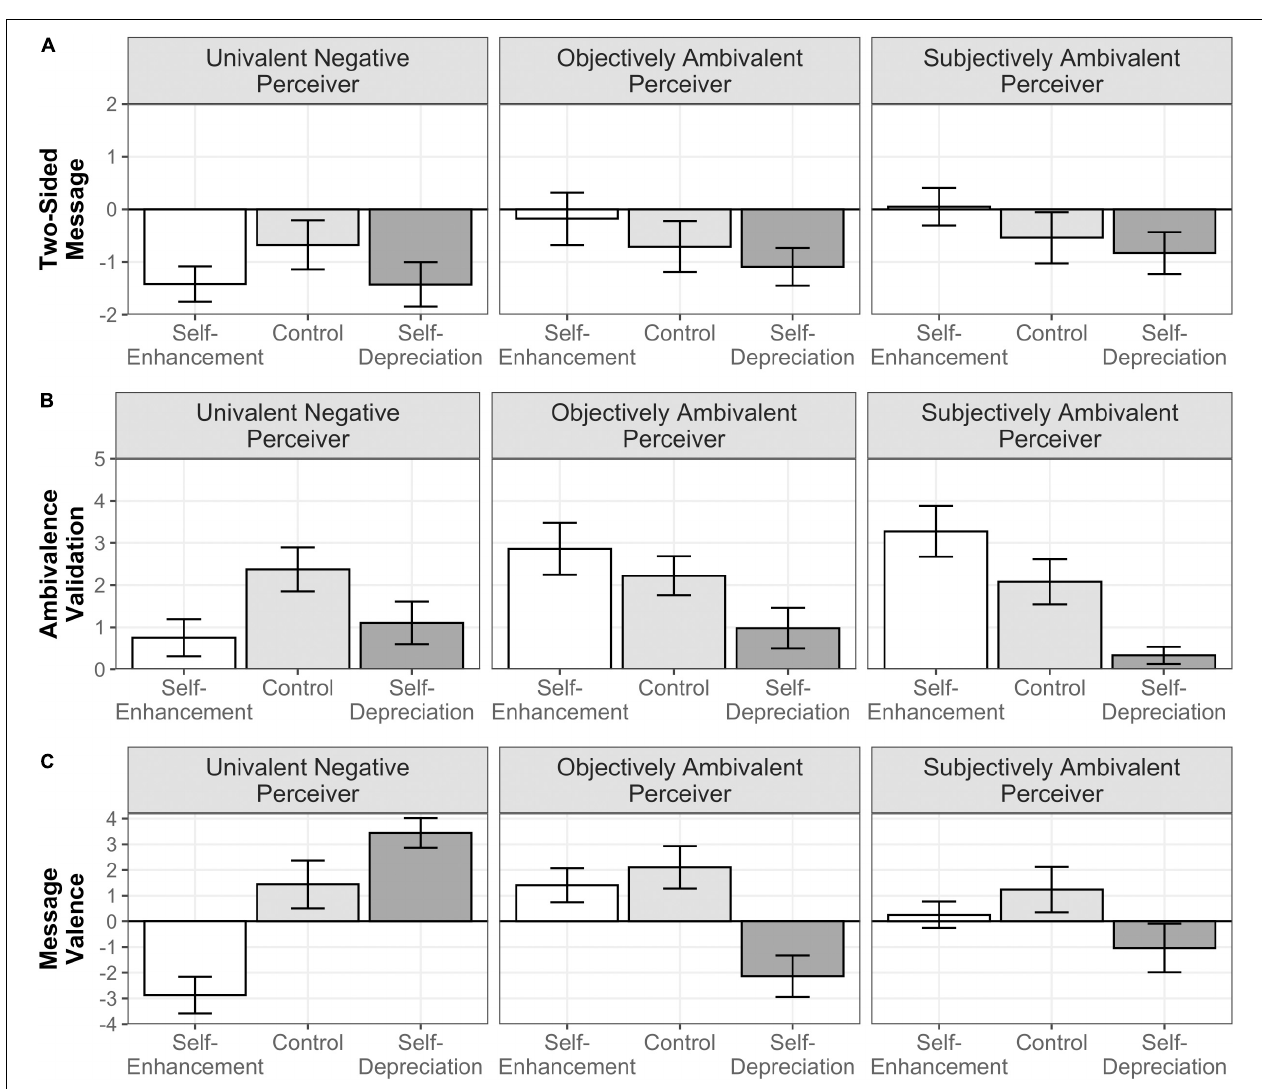
FIGURE 3 | Moderated influence of self-presentation instructions by the perceiver’s attitudinal profile on message ambivalence (A) , ambivalence validation (B) , and message valence (C) in Study 2. Error bars represent 97.52%